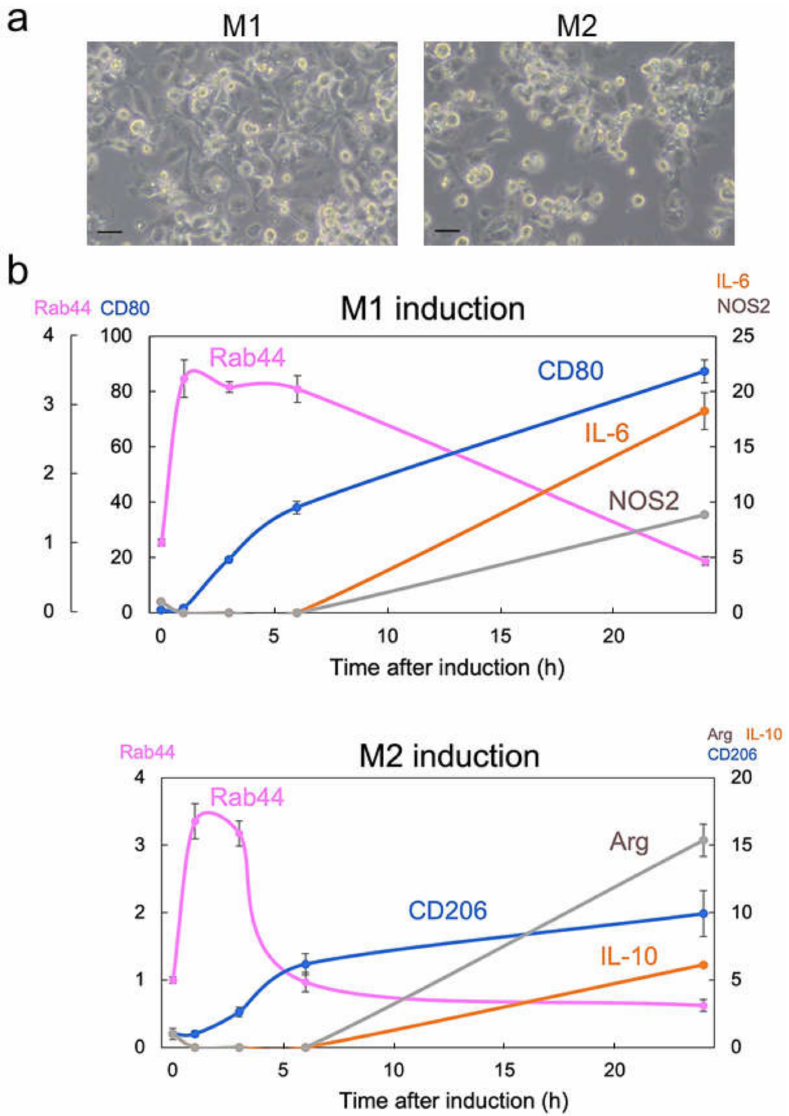
Figure 1. Upregulation of Rab44 in macrophage differentiation. THP-1 cells were induced to M0 macrophages by treatment with phorbol 12-myristate 13-acetate (PMA) (100 nM) at 37 ◦ C for 24 h. M0 macrophages were differentiated into M1 macrophages by incubation with lipopolysaccharide (LPS) (0.1 mg/mL) and interferon (IFN)- γ (20 ng/mL), or M2 macrophages by incubation with IL-4 (20 ng/mL) and IL-13 (20 ng/mL) at 37 ◦ C for 0–24 h. ( a ) Representative images of M1- and M2-type macrophages are shown. Bars: 20 µ m. ( b ) Quantitative RT-PCR determination of Rab44 mRNA expression in M1- or M2-type macrophages for the indicated times. Data are represented as the mean ± S.E. of values from three independent